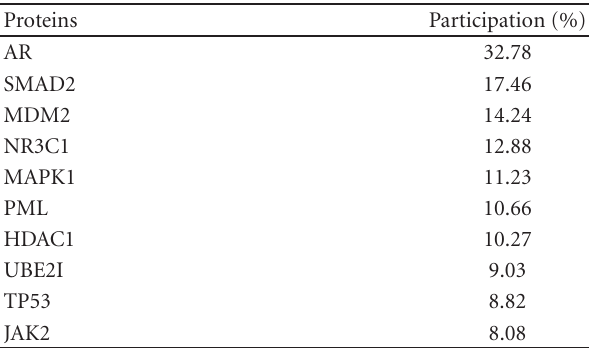
Table 3: The top 10 proteins that participate in 7176 linear